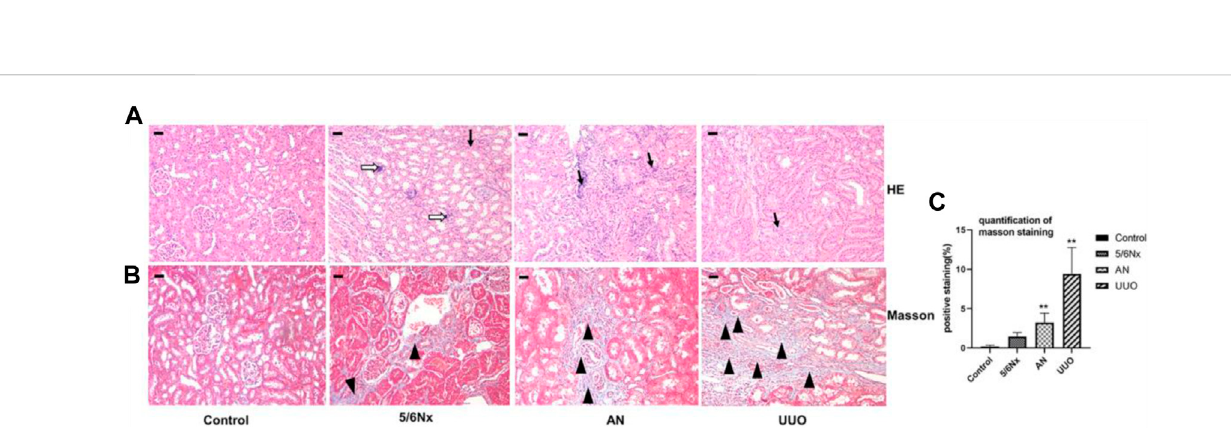
Levels of i-PTH, OC, and CTX-1 in serum in different models. (A) Levels of i-PTH in serum in different models. (B) Levels of OC in serum in different models. (C) Levels of CTX-1 in serum in different models. * p < 0.05 and ** p < 0.01 vs. the control group. Data are presented as mean ± SD. n = 6.